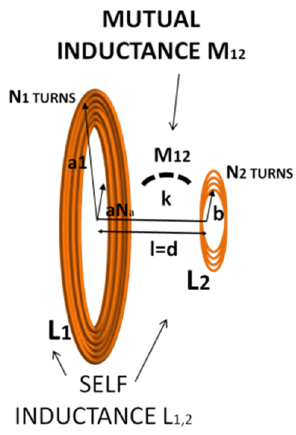
Figure 3. Transmitter (on the left) and receiver (on the right) coils perfectly aligned in a relative fixed